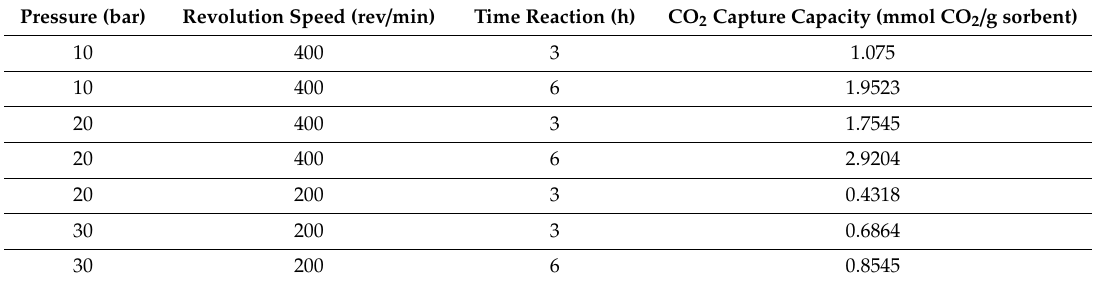
reaction in the mechanochemical